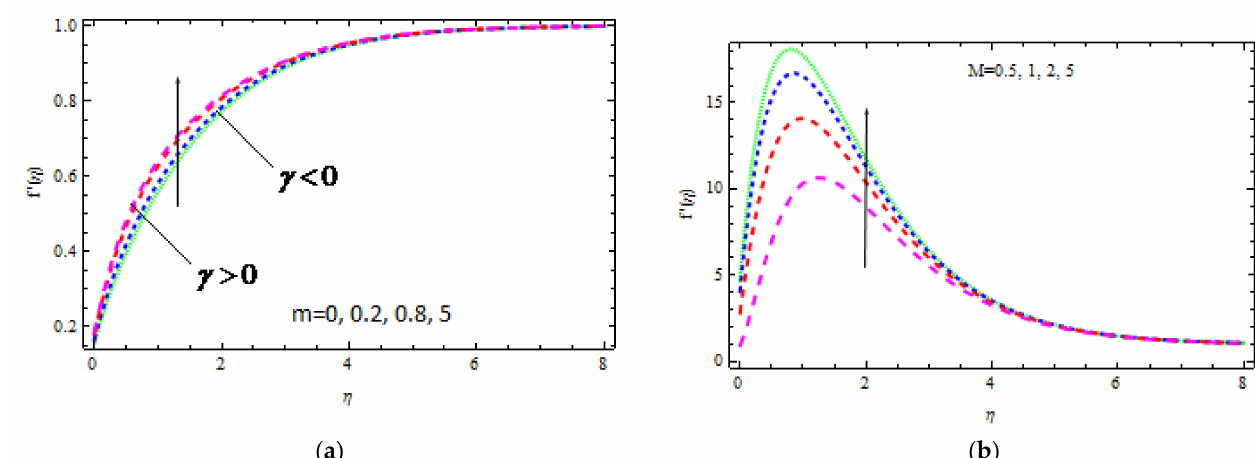
Figure 3. Inspiration of m ( a ) and M ( b ) on velocity.